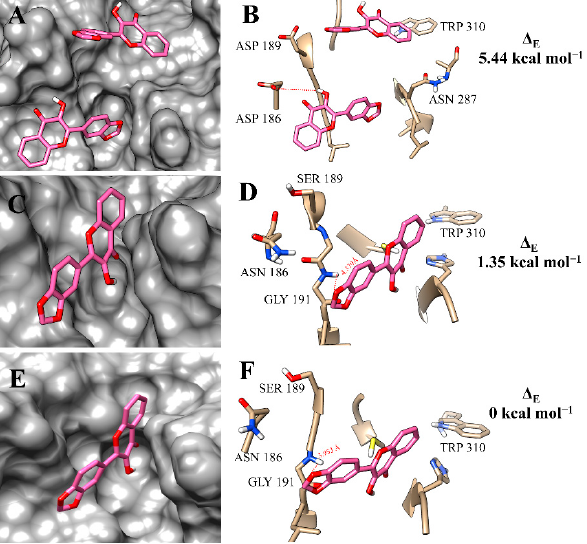
Figure 7. Binding mode positions of flavonol f12b at the active site of rCPB2.8 ( A , B ), rCPB3 ( C , D ), and rH84Y ( E , F ). The hydrogen bonds are represented by a red dashed line.